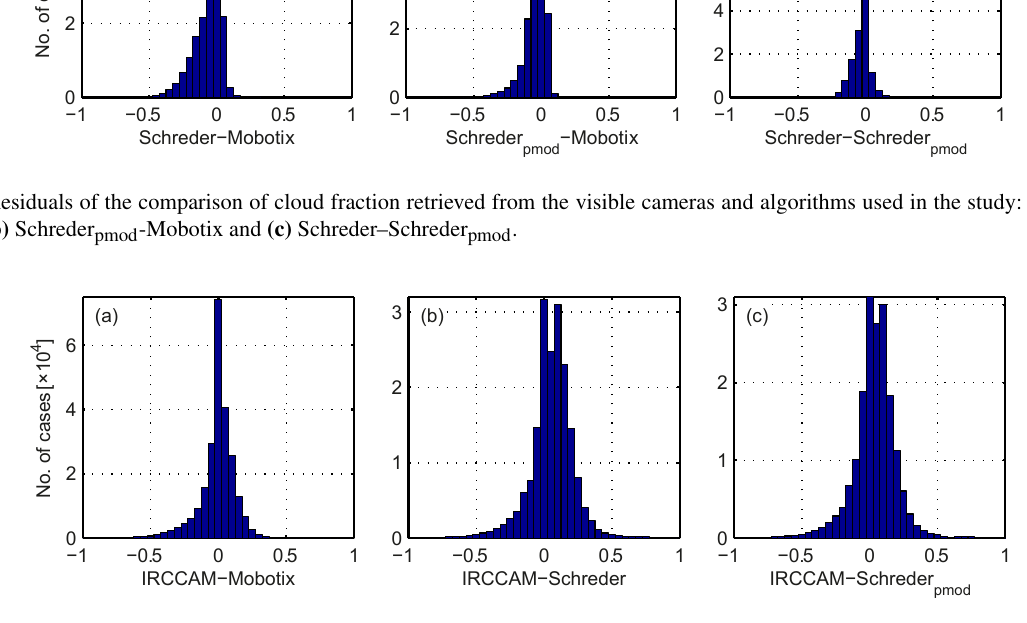
Figure 9. Residuals of the comparison of cloud fraction retrieved from the IRCCAM versus cloud fraction retrieved from the visible cameras: (a) IRCCAM–Mobotix, (b) IRCCAM–Schreder and (c) IRCCAM–Schreder pmod .